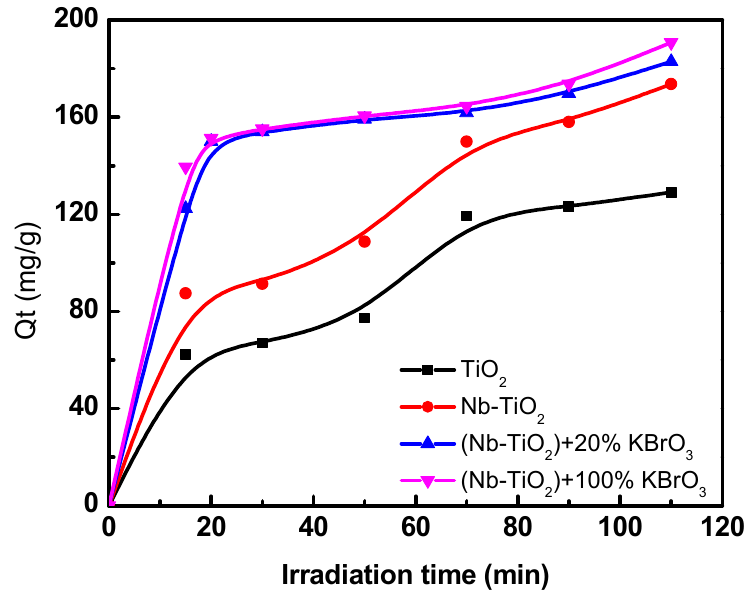
Figure 10. Effect of the degradation quantity of the phenol red concentration as a function of the irradiation time for the pure TiO 2 , Nb-TiO 2 , Nb-TiO 2 /20%KBrO 3, and Nb-TiO 2 /100%KBrO 3 .